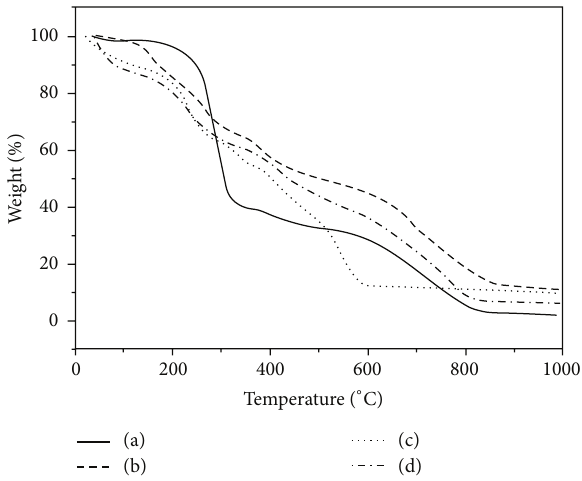
Figure 9: TGA of (a) BEF ligand, (b) BEF–Cu, (c) BEF–Ni, and (d)